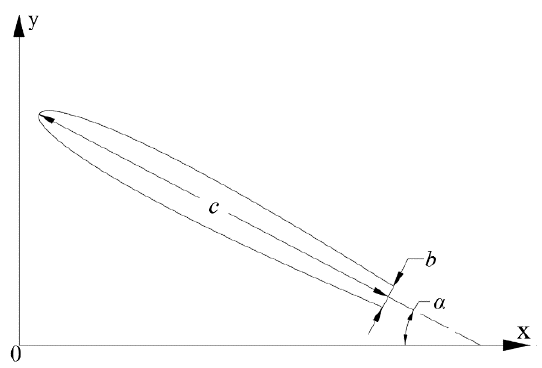
Figure 1. Diagram of the hydrofoil model.